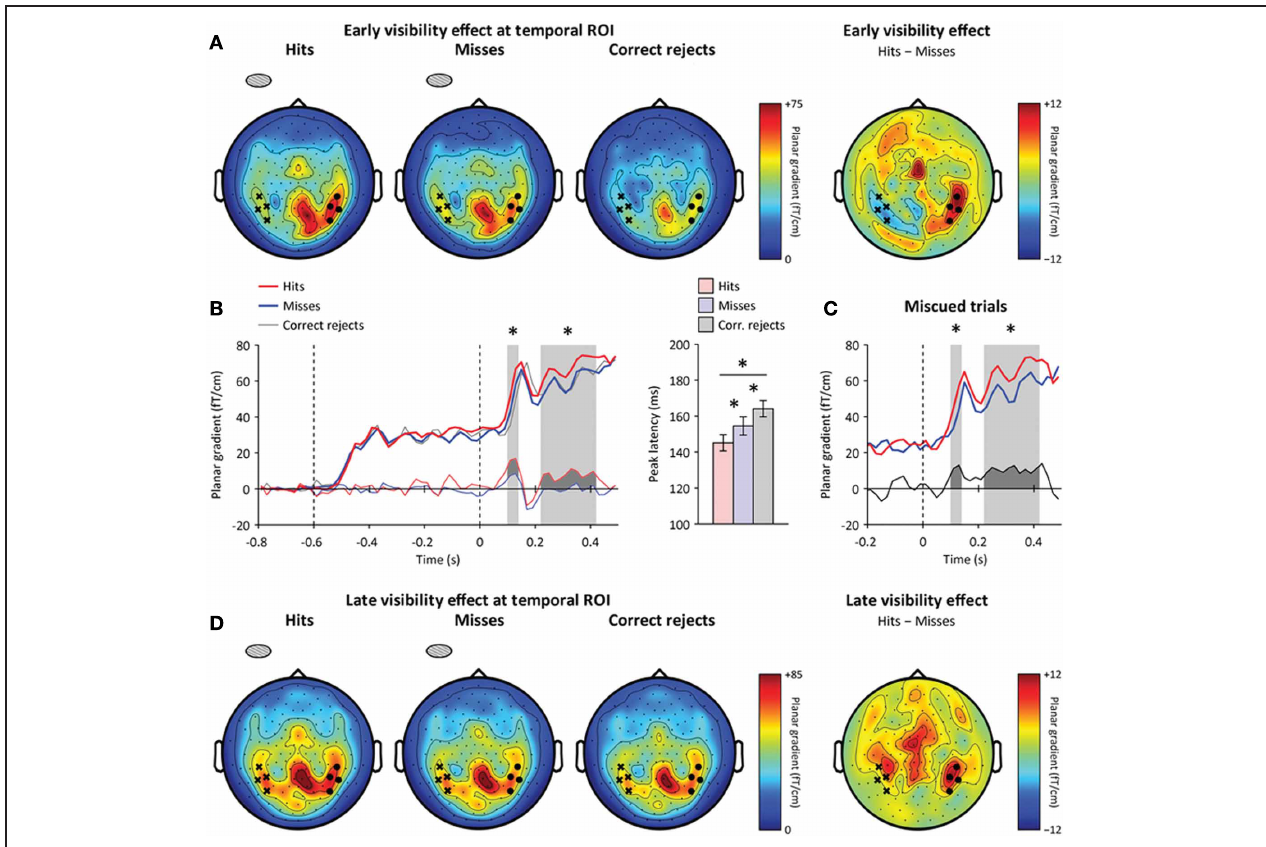
FIGURE 5 | Neural correlates of conscious detection. (A) Early awareness-dependent effect. Left: Sensor-level topography of neuromagnetic event-related signals at 110–130ms following target onset (left: hits, center: misses, right: correct rejects). The contralateral (ipsilateral) temporal ROI is highlighted by black dots (crosses, respectively). Right: Sensor-level topography of the awareness-dependent effect (hits minus misses). The early awareness-dependent effect peaks at the contralateral temporal ROI. (B) Left: Time course of contralateral signals at the temporal ROI for hits (red), misses (blue), and correct rejects (gray). The thin red (blue) lines below indicate the amplitude difference between hits (misses) and correct rejects (respectively).